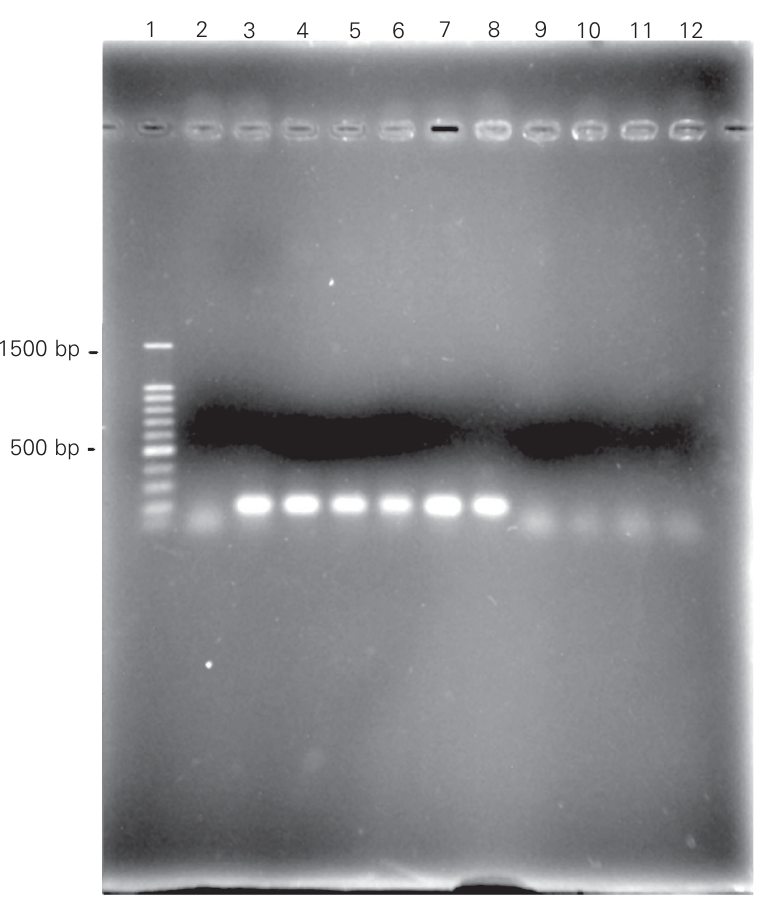
Figure 3. Demonstration of transposon Tn 1546 in vancomycin-resistant isolates of Entero- coccus faecalis by PCR. The 168-bp product corresponded to the amplification of Tn 1546. Lane 1 , Molecular weight in bp; lane 2 , E. faecalis ATCC 29212; lanes 3 to 5 , vancomycin- resistant E. faecalis from Hospital das Clínicas, Universidade de São Paulo; lanes 6 to 8 , E. faecalis vancomycin resistant from Centro Médico de Campinas; lanes 9 to 11 , E. faecalis vancomycin-susceptible from Universidade Estadual de Campinas; lane 12 , negative